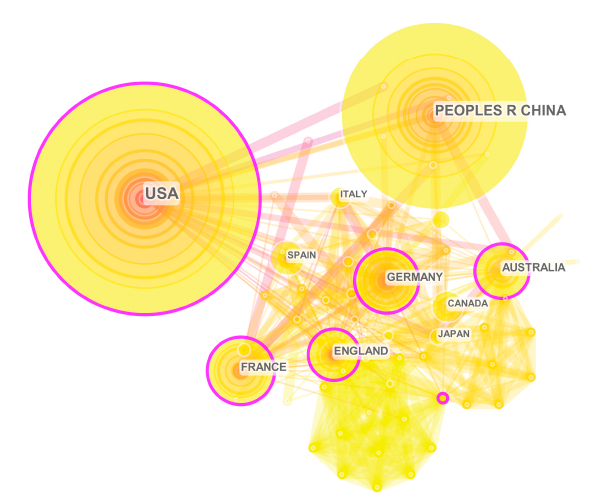
Figure 3. Country collaboration network map.